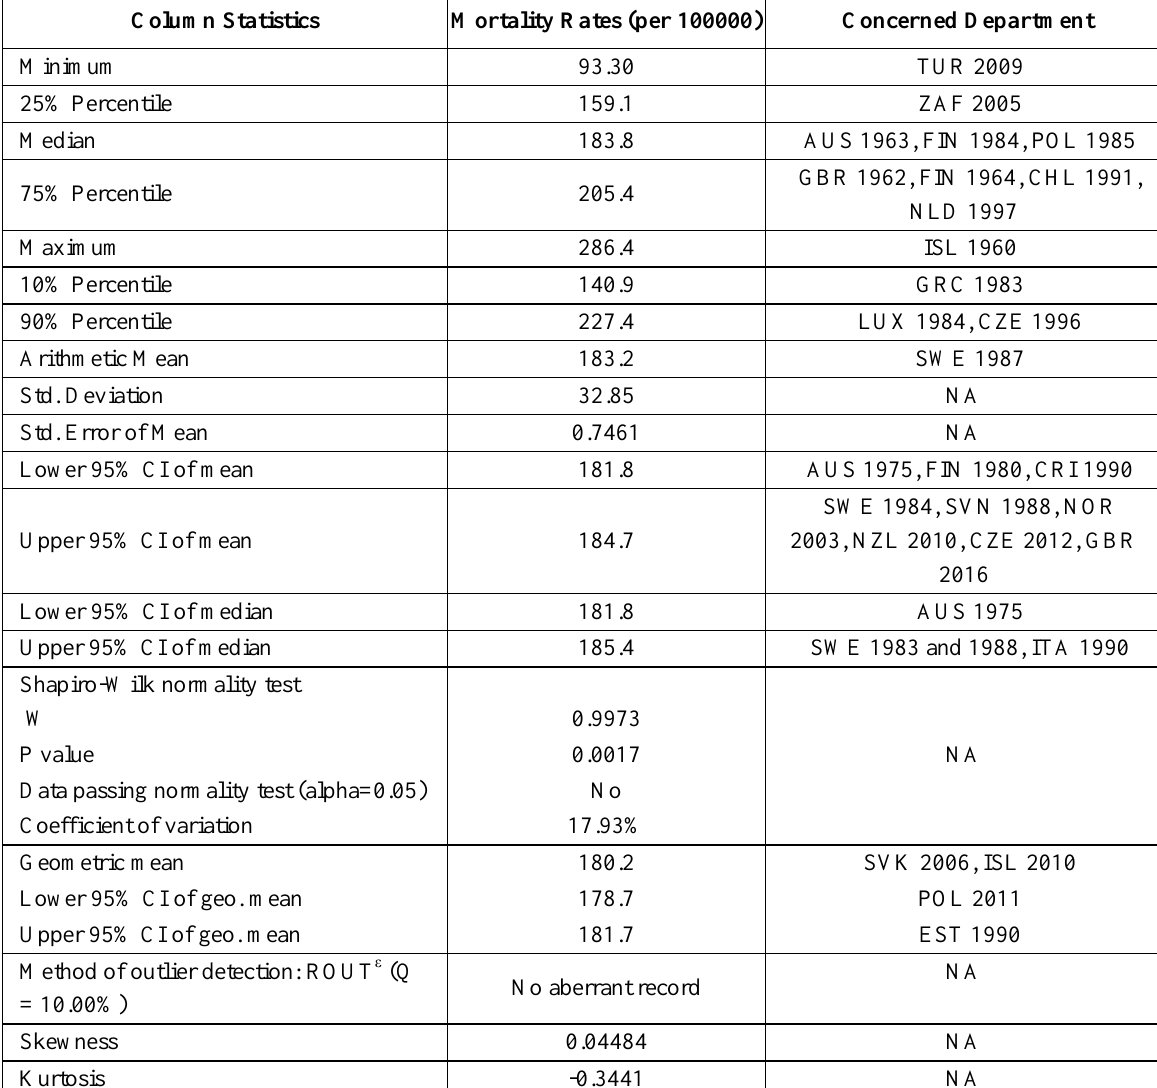
Table 1 : Descriptive statistics of the cancer mortality rates showing the number of deaths per 100000 individuals at CI * 95% and the corresponding countries numerically to the parameters value using Prism - GraphPad